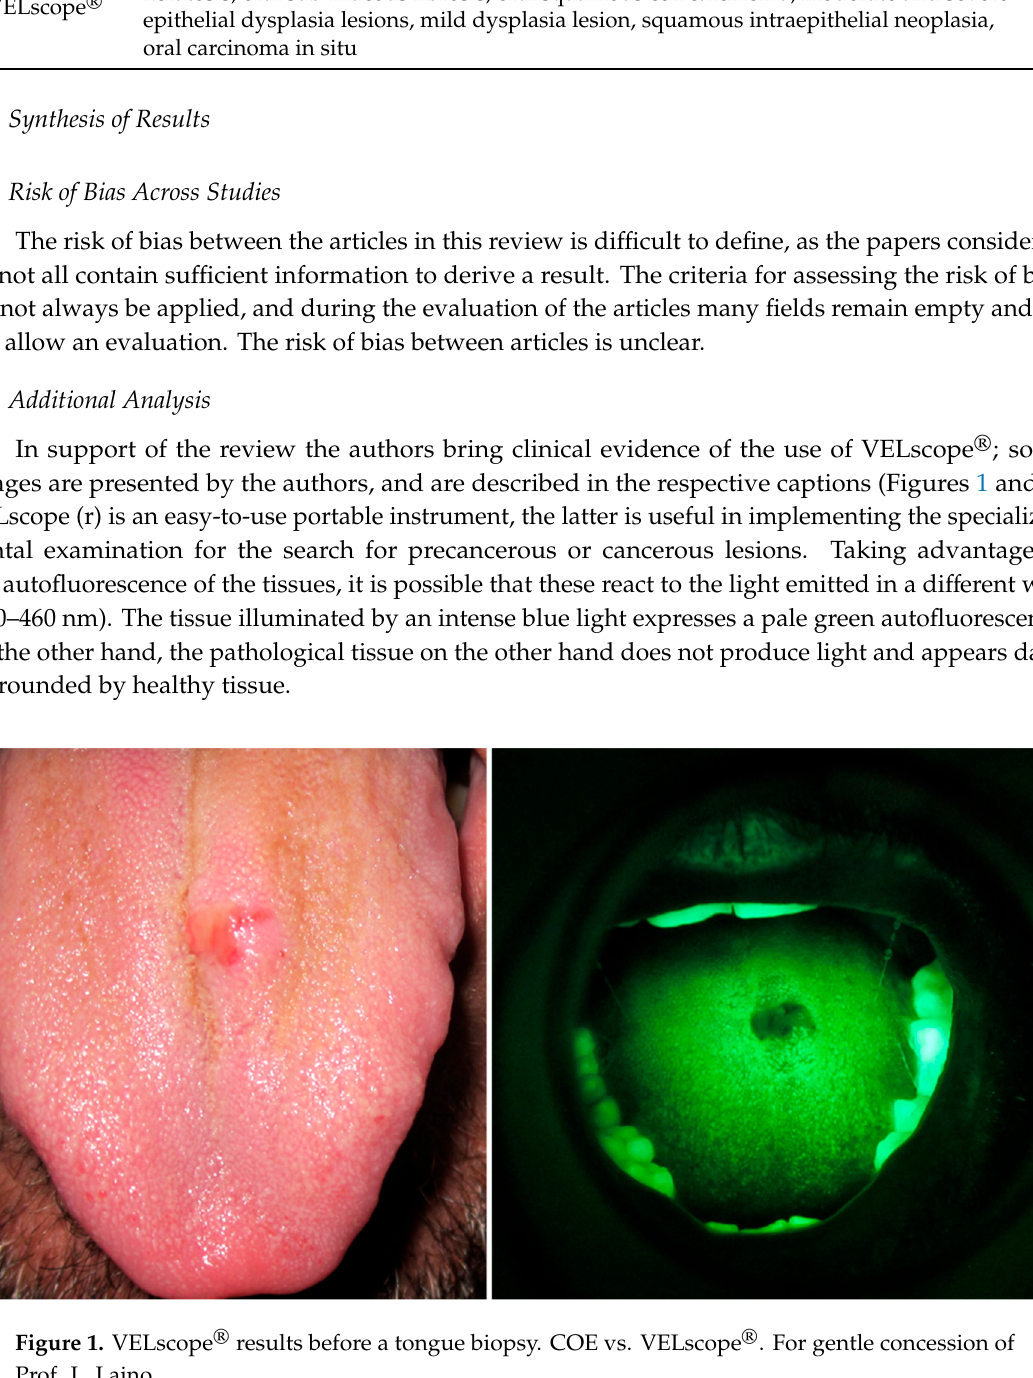
Table 3. Field of use.